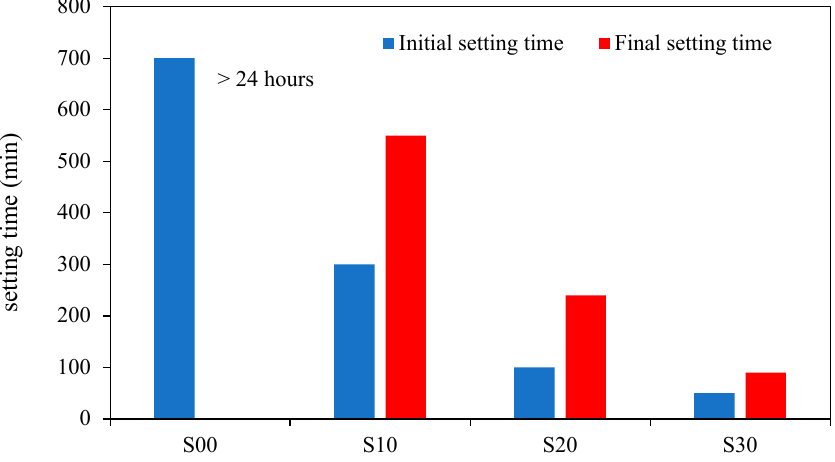
Figure 16. Slag variation during the initial and final setting times [16].